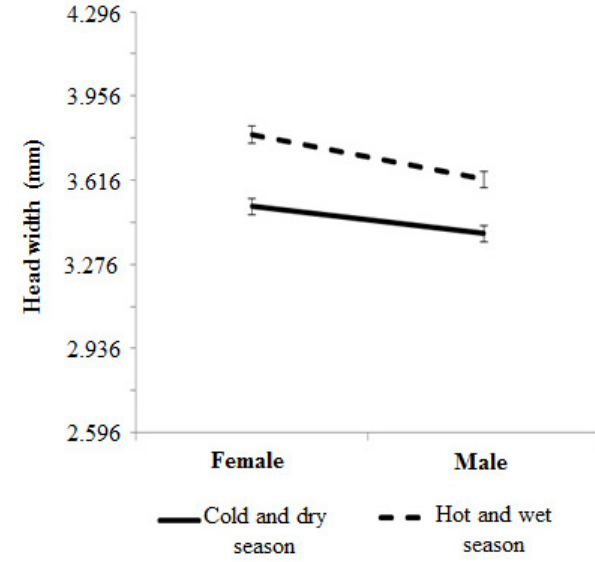
Fig 4 - Maximum head width in millimeters (averages ± standard error) of Tetrapedia curvitarsis collected between the seasons (cold and dry season and hot and wet season) in the period from April 2012 to March 2013, at the Água Limpa Experimental Station, Uberlândia-MG.